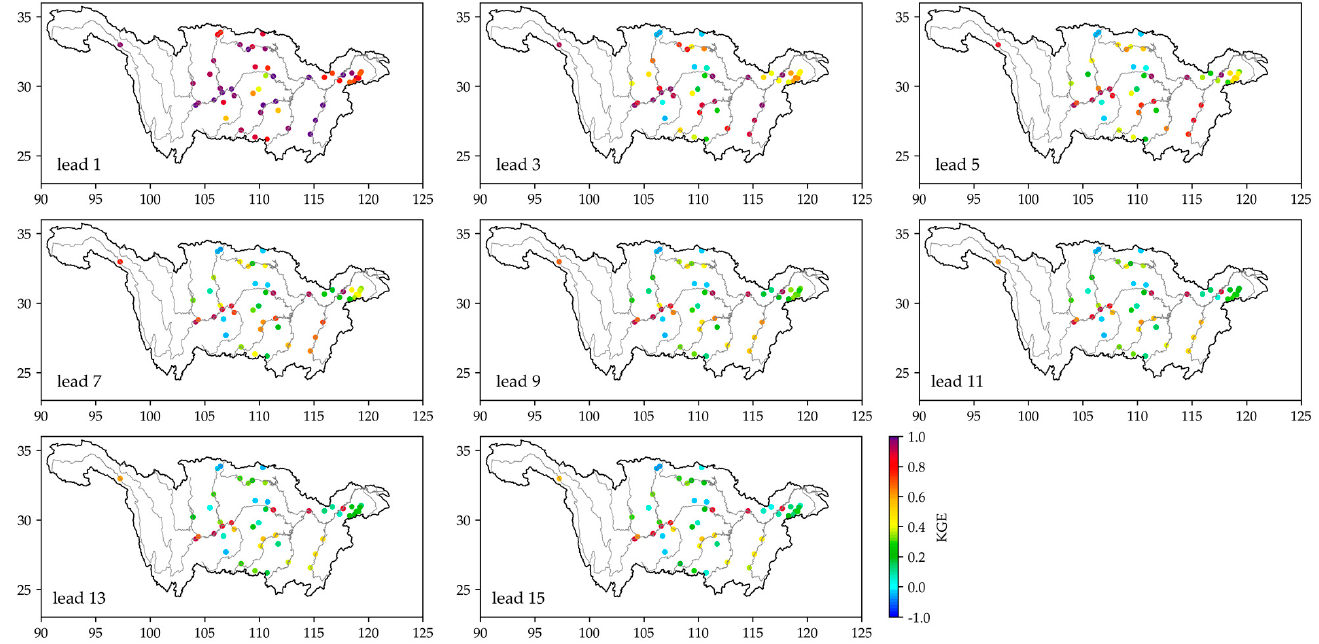
Figure 4. Spatial distributions of KGEs for streamflow forecasts based on default LSTM model at lead times of 1–15 days.